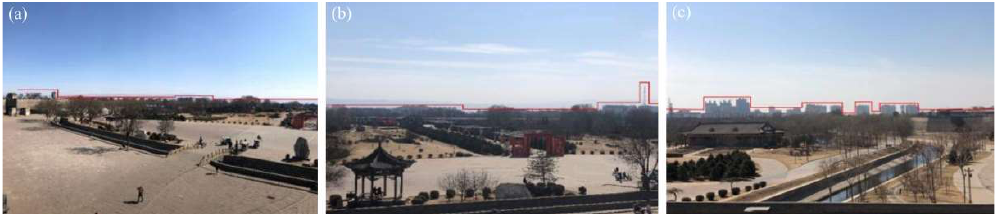
Figure 6. Views from the south gate tower facing west ( a ), south ( b ), and east ( c ). (Author’s photos).